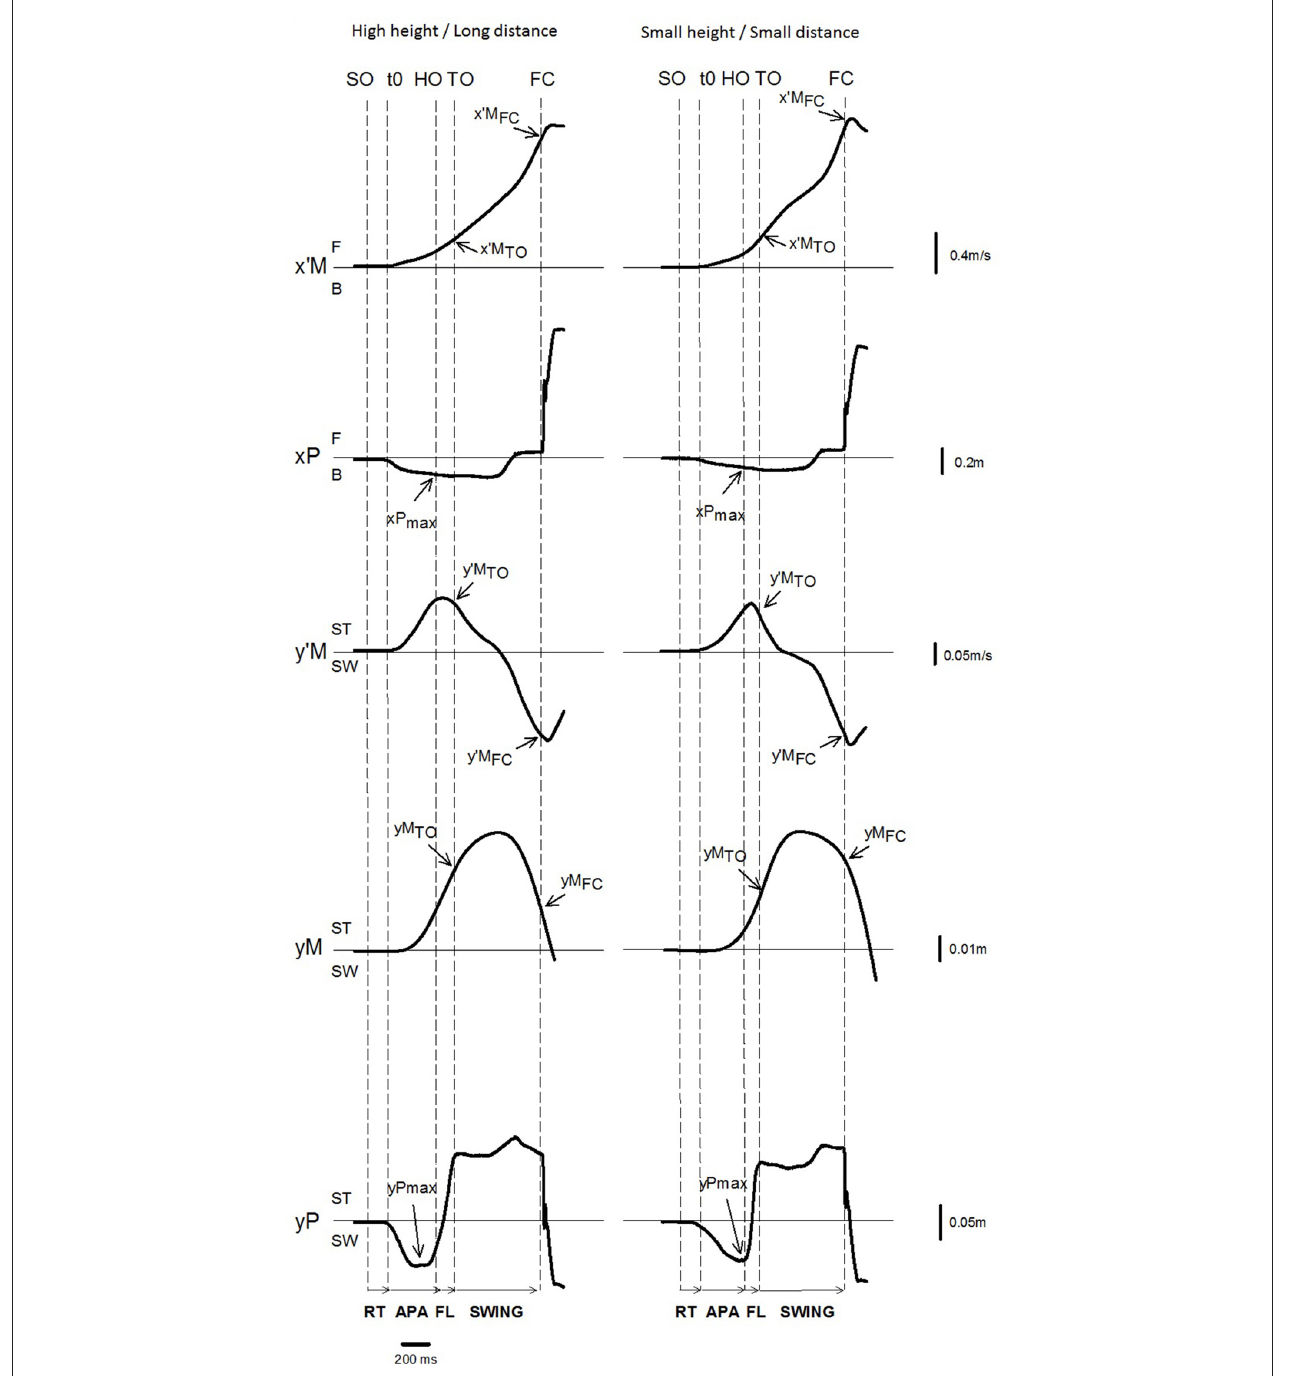
FIGURE 3 | Example of biomechanical traces and representation of the main experimental variables obtained for one representative subject initiating gait (one trial) in the reaction-time condition with the high height/long distance condition (left) and the small height/small distance condition (right). Anteroposterior (AP) direction x (cid:48) M: center of mass (COM) velocity; x (cid:48) M TO , x (cid:48) M FC : COM velocity at foot off and at foot contact. xP: center of pressure (COP) displacement; x Pmax: peak of COP displacement during APAs; F: forward; B: backward. Mediolateral (ML) direction y (cid:48) M: ML COM velocity; y (cid:48) M TO , y (cid:48) M FC: COM velocity at foot off and foot contact; yM: ML COM displacement; yM FC : COM displacement at foot contact; yP: ML COP displacement; yPmax: peak of COP displacement during APAs; and ST: stance limb; SW: swing limb. Vertical dashed lines SO: Go signal onset (in the reaction-time condition only); t 0 onset variation of biomechanical traces; HO: swing heel off; FO: swing foot off; FC: swing foot contact. Horizontal arrows : RT: time-windows for reaction-time; APA: anticipatory postural adjustments FL: foot lift; SWING: swing phase.